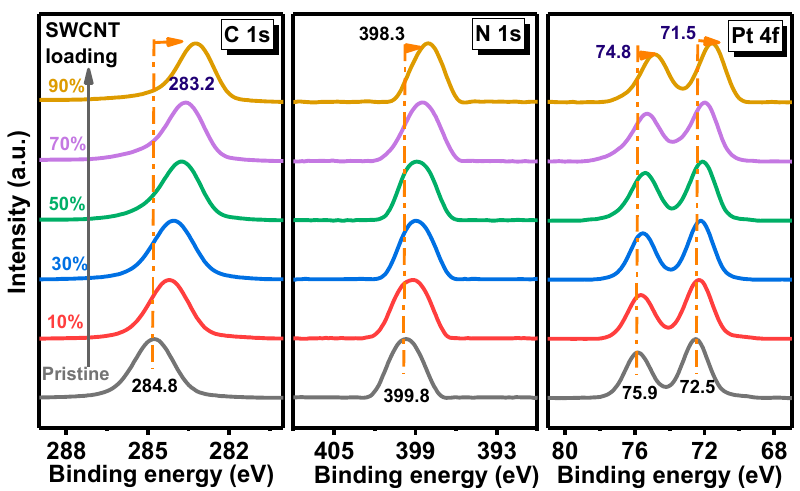
Figure 7. The C 1s, N 1s and Pt 4f spectra of the P(TBT-Pt)/SWCNT composite films.